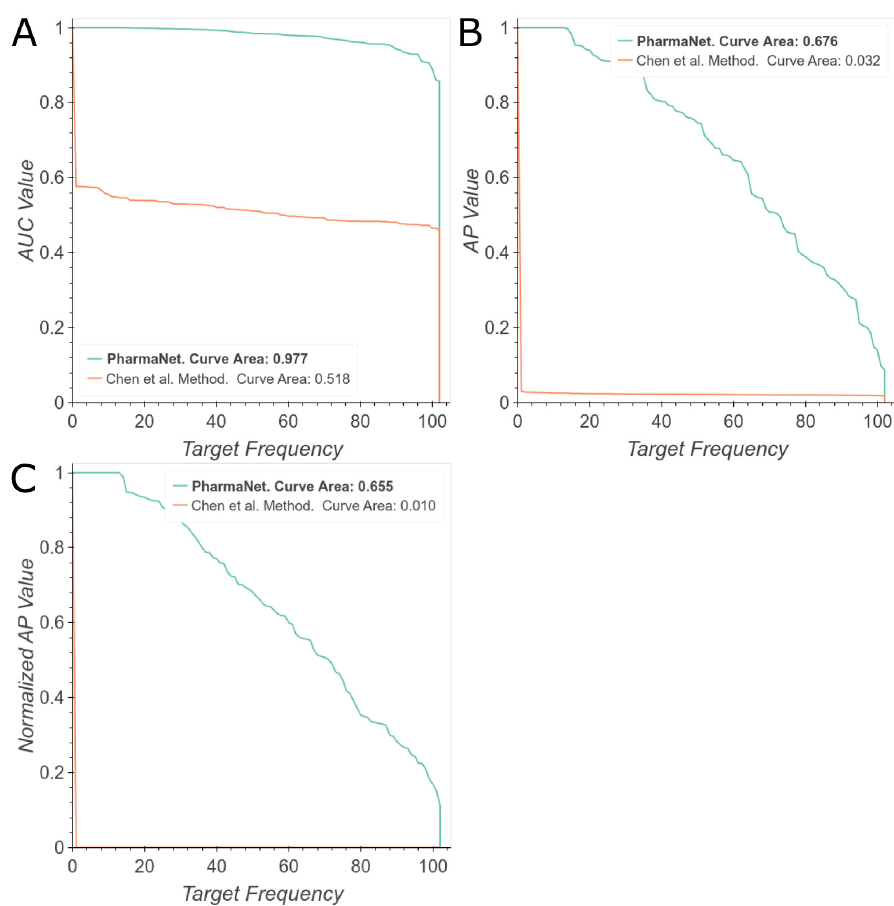
Fig 3. Comparison of PharmaNet against the state-of-the-art method of [24]. The curves correspond to the frequency in the 102 targets for each metric score: (A) Area Under the ROC Curve, (B) Average Precision, (C) Normalized Average Precision. We report area under the frequency curve. Best viewed in